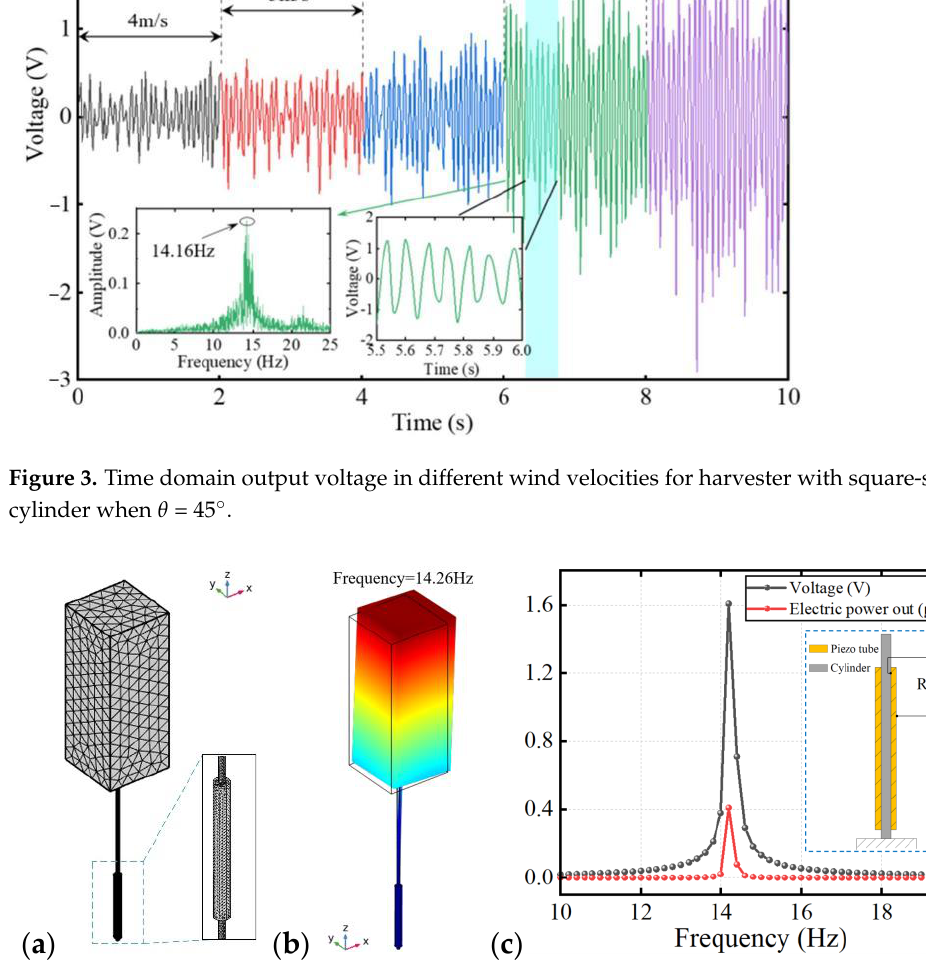
Figure 3. Time domain output voltage in different wind velocities for harvester with square-section cylinder when θ = 45°.